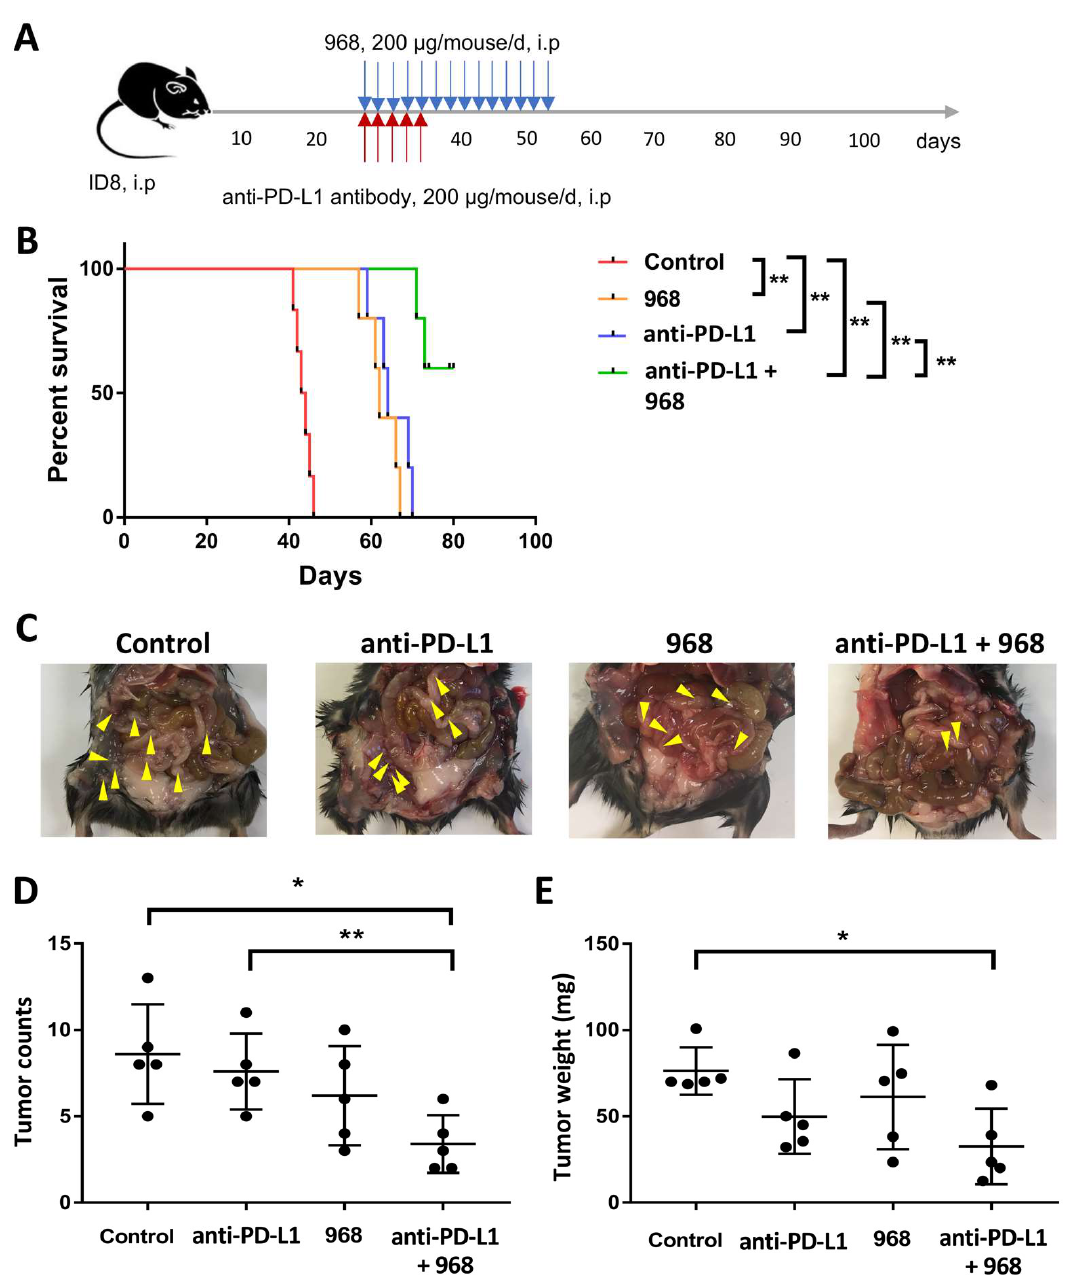
Figure 4. Treatment with glutaminase inhibitor 968 and anti-PD–L1 antibody increased overall survival in the ID8 ovarian cancer model. ( A ) The scheme of therapeutic. ( B ) Overall survival of mice treated with glutaminase inhibitor 968 and/or anti–PD–L1 antibody. ** p < 0.01. ( C ) The typical presentation of ID8 ovarian cancer in C57BL/6 mice treated with glutaminase inhibitor 968 and/or anti–PD–L1 antibody. ( D , E ) The peritoneal tumors were counted and weighed after euthanization. Each dot represents one mouse (* p < 0.05, ** p < 0.01).